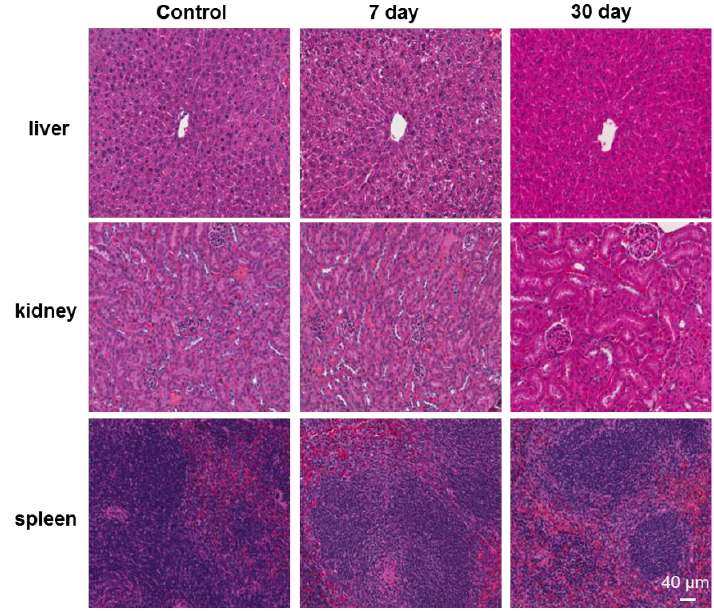
Figure 5. Representative organ histology images of control and QDs treated mice. QDs treated organs were collected 7 days or 30 days after intravenous injection of QDs. (Scale bar: 40 μm).